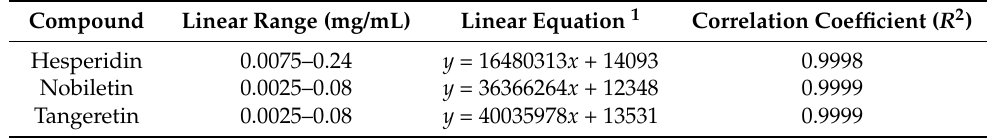
Table 1. HPLC calibration curves for hesperidin, nobiletin, and tangeretin. Compound Linear Range